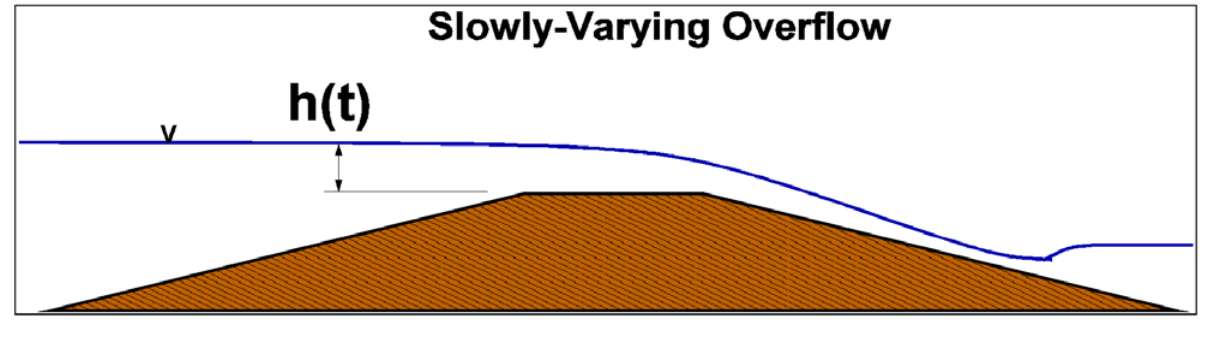
Figure 4. Slowly-varying overflow of a